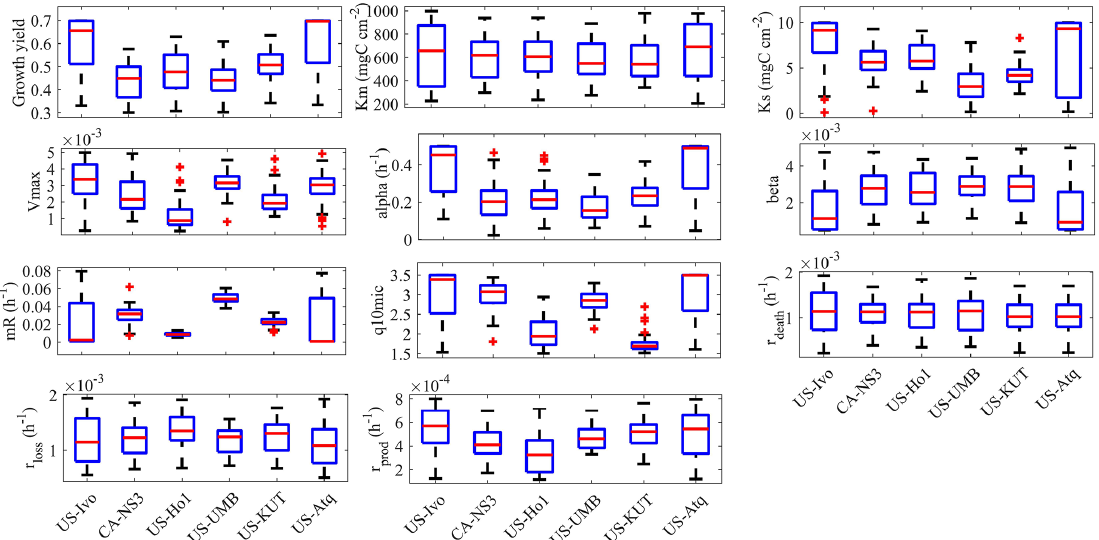
Figure 3. Box plot of parameter posterior distributions that are obtained after ensemble inverse modeling for MIC-TEM-dormancy for all six sites: US-Ivo: Ivotuk (alpine tundra), CA-NS3: UCI-1964 burn site (boreal forest), US-Ho1: Howland Forest (temperate coniferous forest), US-UMB: Univ. of Mich. Biological Station (temperate deciduous forest), US-KUT: KUOM turf-grass field (grassland), US-Atq: Atqasuk (wet